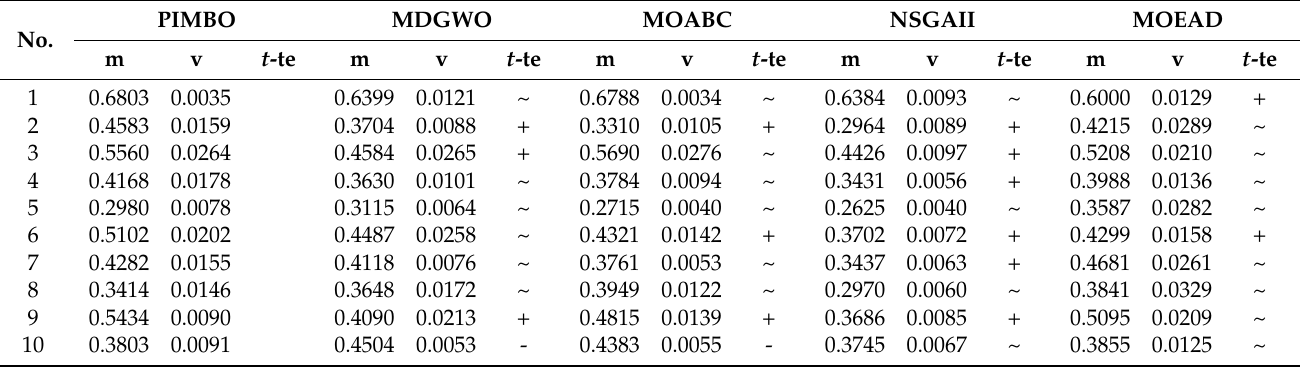
Table 6. Comparison of the experimental results of the five algorithms through the hypervolume